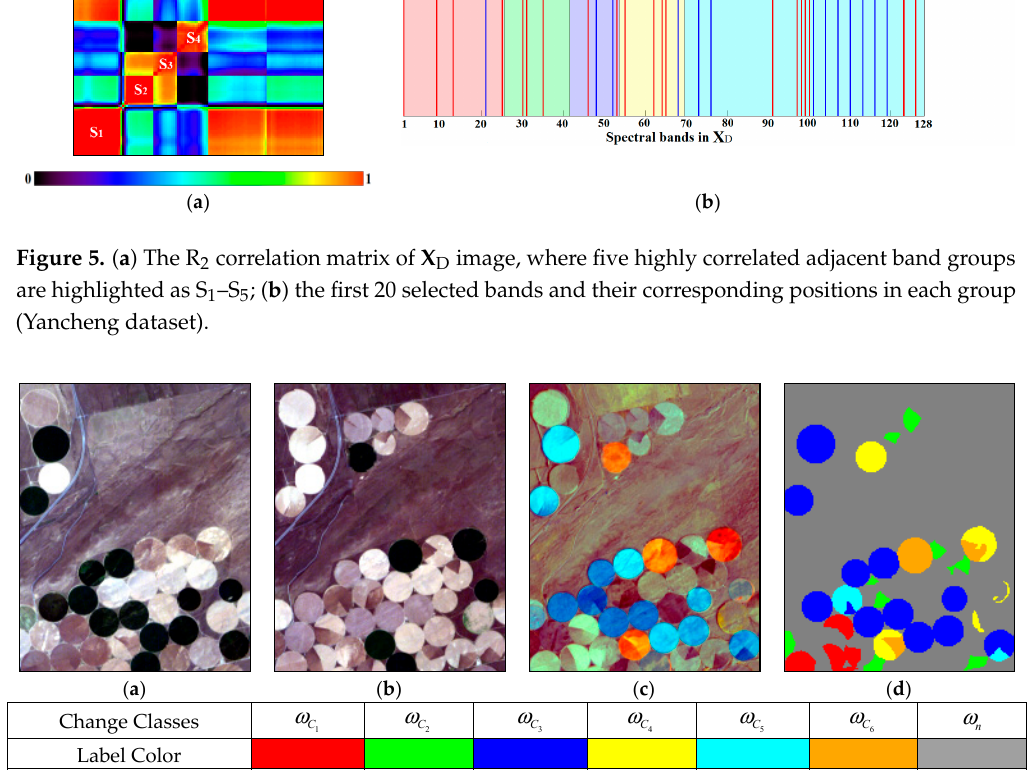
Figure 6. False color composite (R: 650.67 nm, G: 548.92 nm, B: 447.17 nm) of the bi-temporal EO-1 Hyperion images acquired over an irrigated agricultural area in Umatilla County (USA) in ( a ) 2004 (X 1 ) and ( b ) 2007 (X 2 ); ( c ) composite of three SCV channels (R: 823.65 nm, G: 721.90 nm, B: 620.15 nm); ( d ) change reference map. Six changes are in different colors, whereas unchanged pixels are in gray.